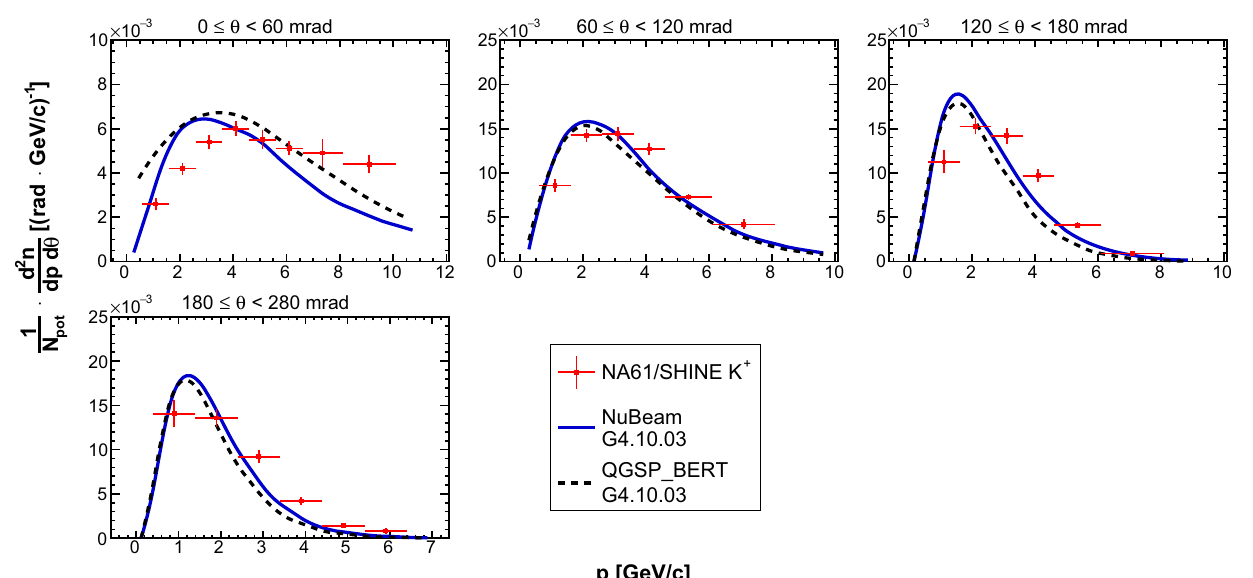
Fig. 39 Double differential yields of positively charged kaons for the fifthupstreamlongitudinalbin(72 ≤ z < 90cm).Verticalbarsrepresent the total uncertanties. Predictions from the NuBeam (solid blue line)